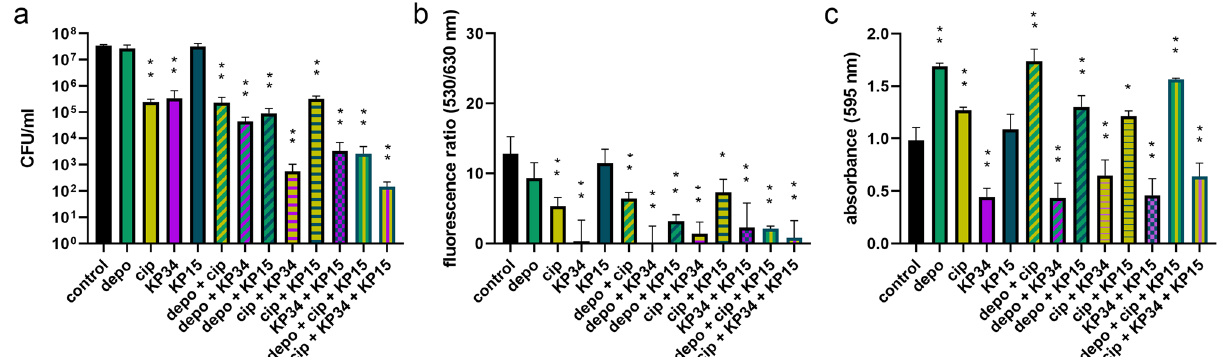
Figure 4. The antibiofilm activity of combined preparations composed of KP34p57 recombinant depolymerase (depo) at concentration corresponding to 10 MHF (minimal halo forming concentration), ciprofloxacin (cip) at concentration corresponding to 4 MIC (minimal inhibitory concentration), lytic phage KP34 specific to K. pneumoniae 77 (KP34, 10 8 PFU/ml), and lytic phage KP15 non-specific to K. pneumoniae 77 (KP15, 10 8 PFU/ml) on K. pneumoniae 77 biofilm formed for 72 h on polystyrene pegs. The 72 h biofilm was treated for two hours with different combinations of antimicrobials as indicated under the columns. Plus ( +) between abrreviations indicates that two or three antimicrobials were mixed and used simultaneously. Biofilm eradication was examined with three different microtiter methods: ( a ) the colony count (CFU/ml); ( b ) LIVE/ DEAD BacLight Bacterial Viability Kit with live to dead cells ratio at fluorescence 530/630 nm; ( c ) the crystal violet staining and the level of absorbance at 595 nm. P -value < 0.001 (indicated as two asterisks) and P- value between 0.01 and 0.001 (indicated as one asterisk) were considered statistically